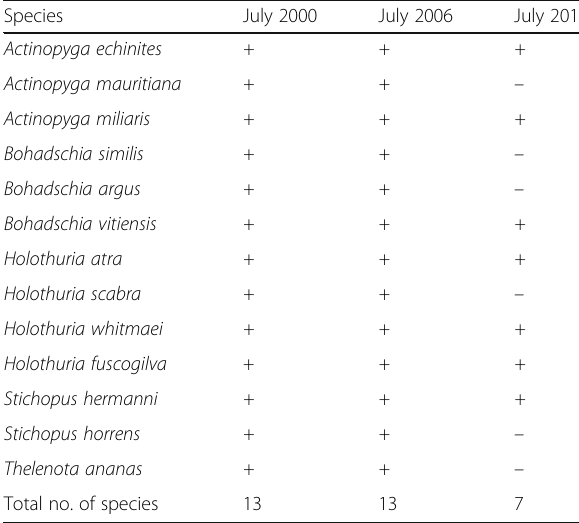
Table 1 Sea cucumber species recorded at Abou Ghosoun area during the period of study (2000, 2006, and 2016)